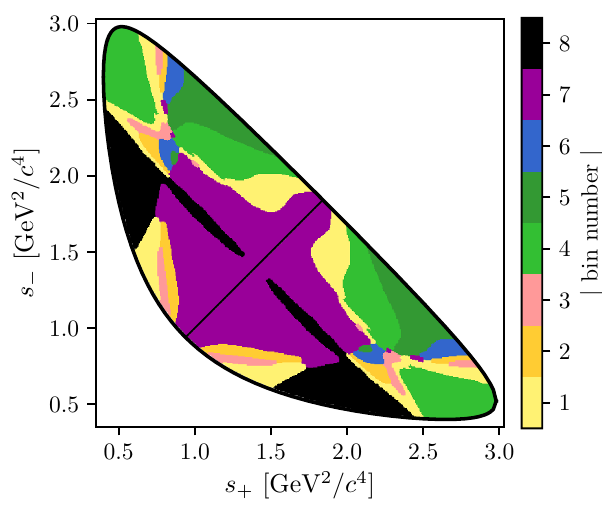
Figure 1 . The optimal binning scheme of the D